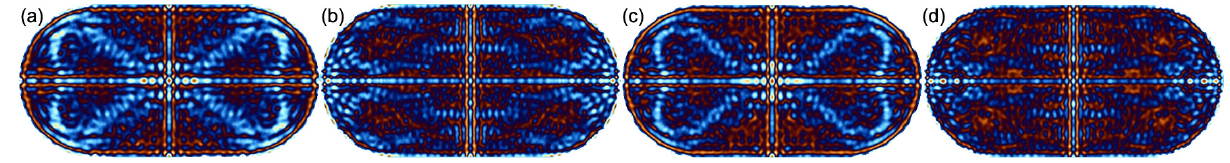
Figure 4: The long-term stability of the scars in the cellular automaton simulation is confirmed when the cases (b) and (f) in Figure 3 are run for a further 3300 iterations and the initial transient states of the generator are thus omitted entirely. (a, b) Iterations 1-3300 superimposed. (c, d) Iterations 3300-6600 superimposed. In these figures the absolute wave amplitudes have been added rather than the squared amplitudes to illustrate various methods of scar highlighting.